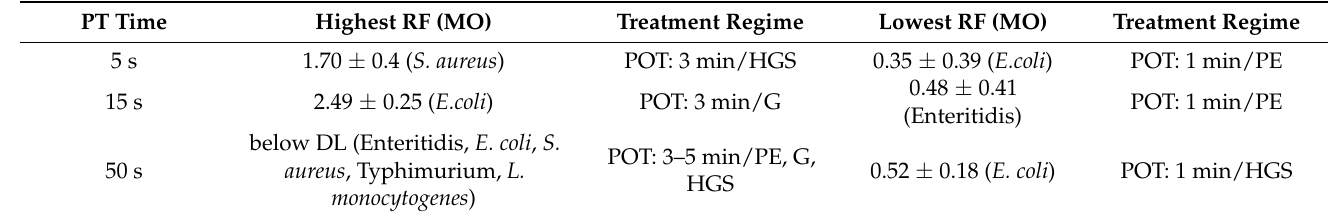
Table 6. Summary of extreme RF values categorized after various PT